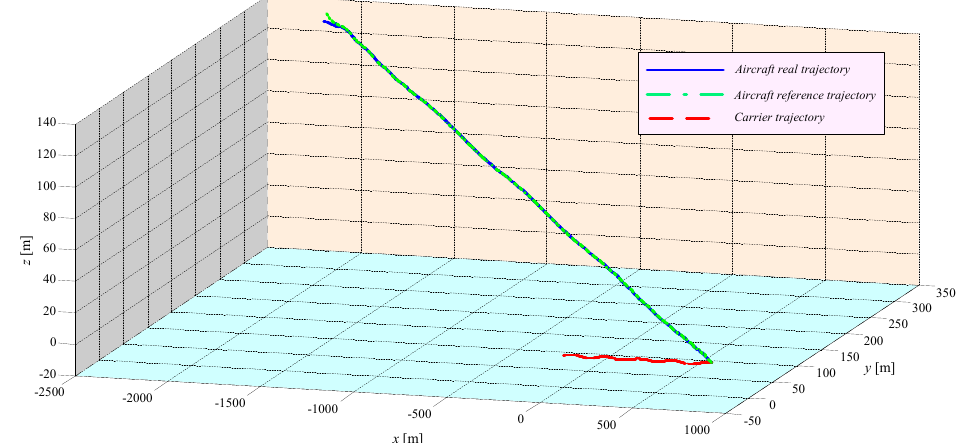
Figure 12. Trajectory of aircraft and carrier.